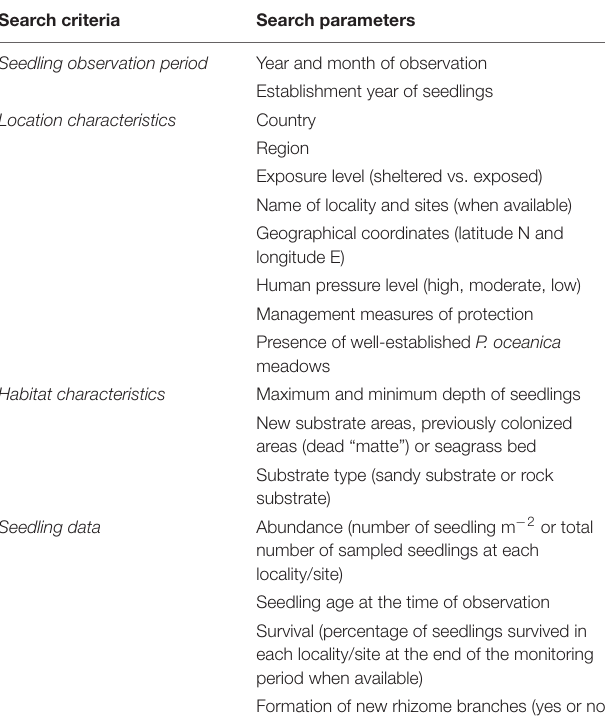
TABLE 1 | Parameters and data gathered from the literature